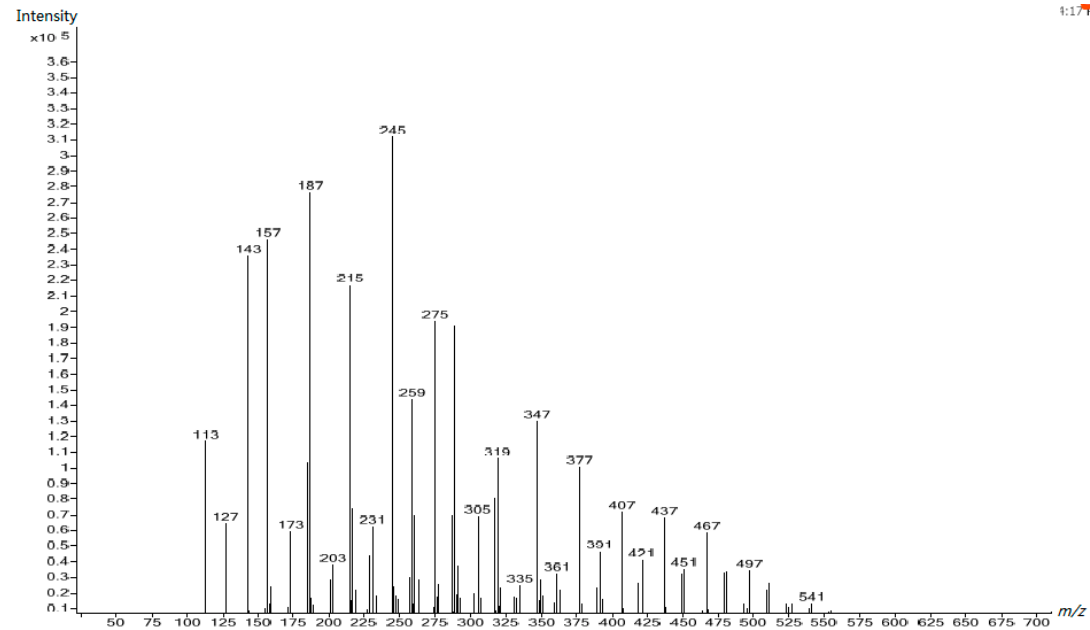
Figure 8. The electrospray ionization mass spectrometry (ESI–MS) spectrum of UF-1.